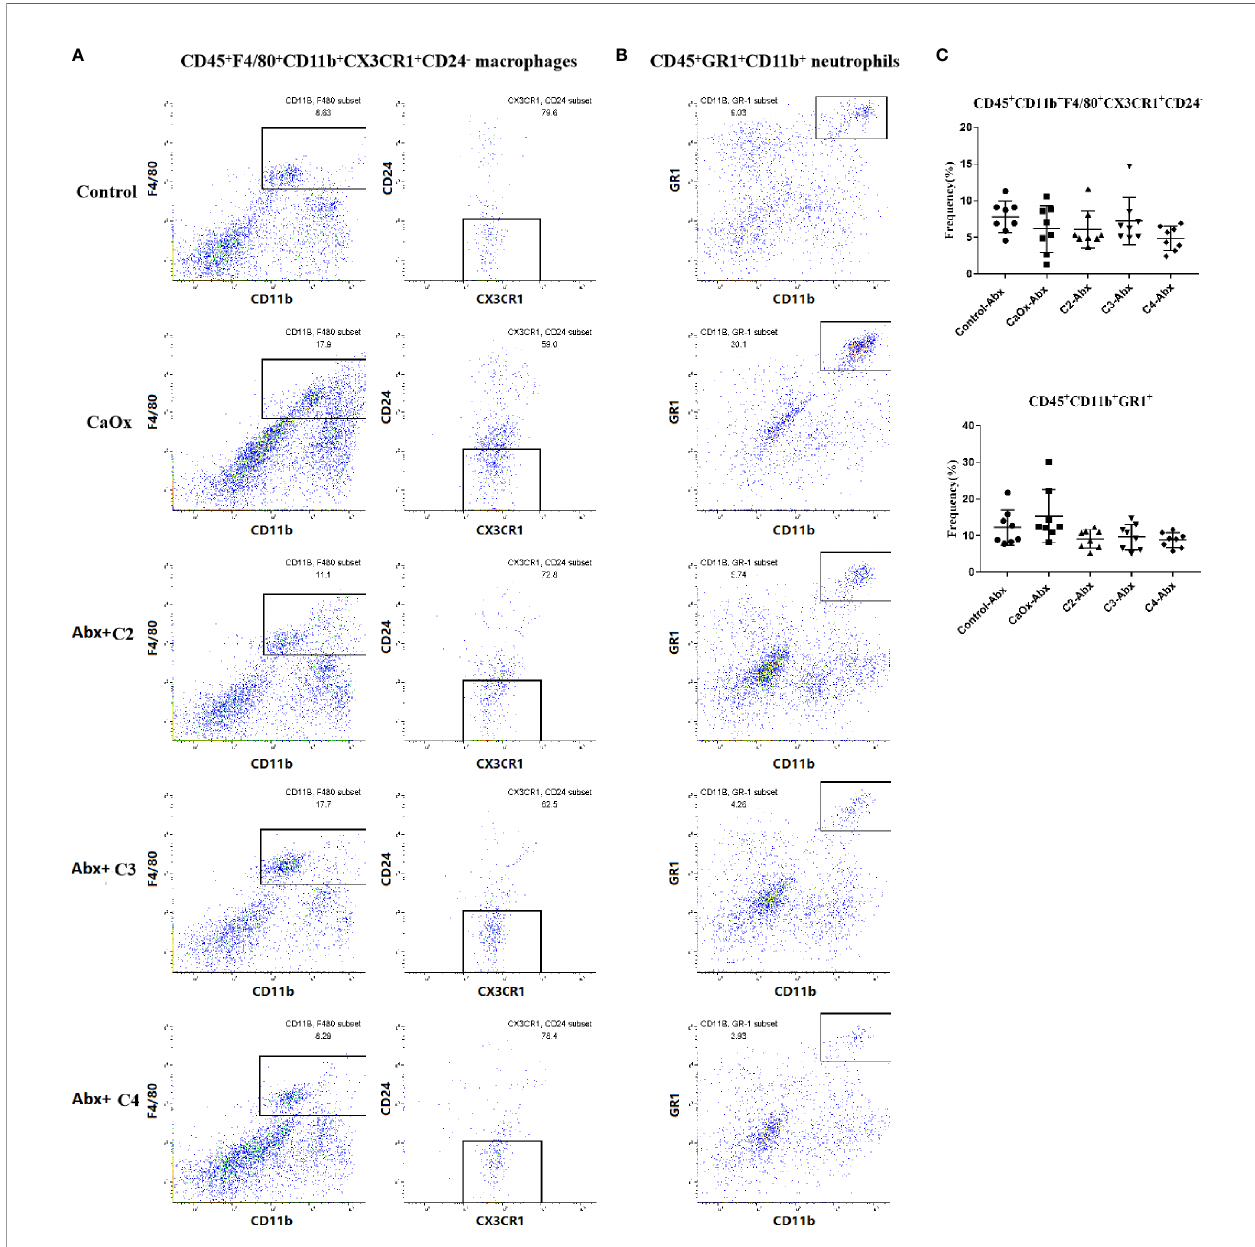
FIGURE 9 | Representative fl ow cytometric analysis of CD45 + F4/80 + CD11b + CX3CR1 + CD24 - macrophages and CD45 + GR1 + CD11b + neutrophil in CaOx crystal mice with administration of SCFAs after treatment of antibiotics. (A) macrophages were fi rst gated on CD45 + cells, and then were gated on F4/80 + CD11b + cells followed by CX3CR1 + CD24 - , and (B) neutrophil were gated as GR1 + CD11b + in CD45 + cells. c Frequencies of CD45 + F4/80 + CD11b + CX3CR1 + CD24 - macrophages and CD45 + GR1 + CD11b + neutrophil in kidney with administration of SCFAs and antibiotics. (C) Frequencies of CD45 + F4/80 + CD11b + CX3CR1 + CD24 - macrophages and CD45 + GR1 + CD11b + neutrophil in kidney. Data were shown as mean ± standard deviation. Data were analyzed by one-way ANOVA followed by Tukey ’ s multiple comparisons test among multiple